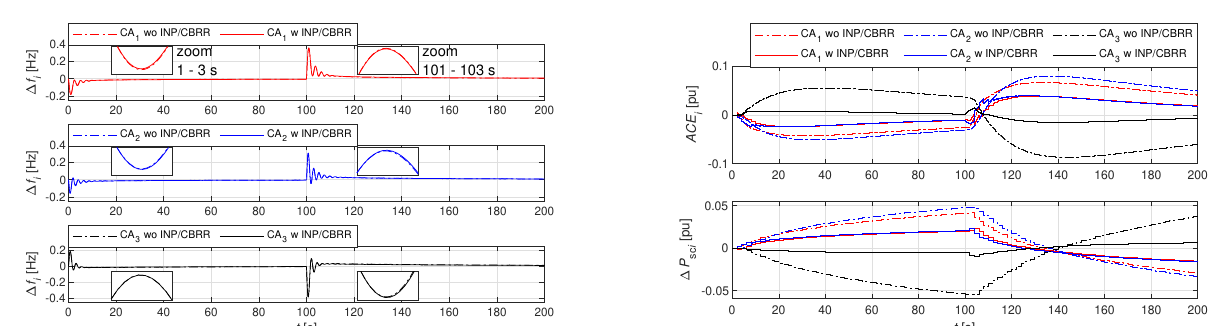
Figure 11. Time responses of ∆ f i ( left ) and time responses of ACE i and ∆ P sc i ( right ) for a three-CA test system, where “wo INP/CBRR” is without and “w INP/CBRR” is with the INP and CBRR.